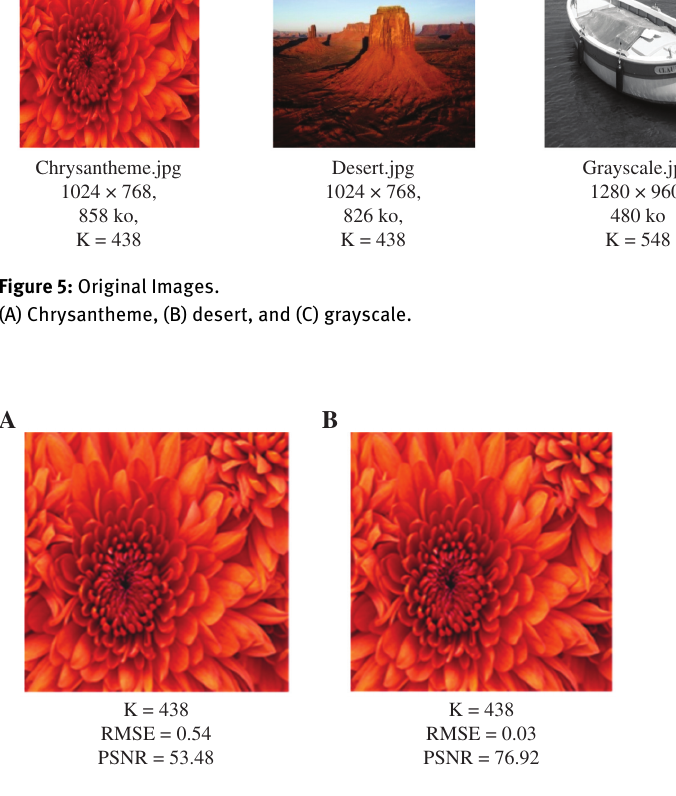
Figure 6: Compressed Results. Compressed results obtained by (A) MATLAB’s SVD function [11] and (B) the proposed